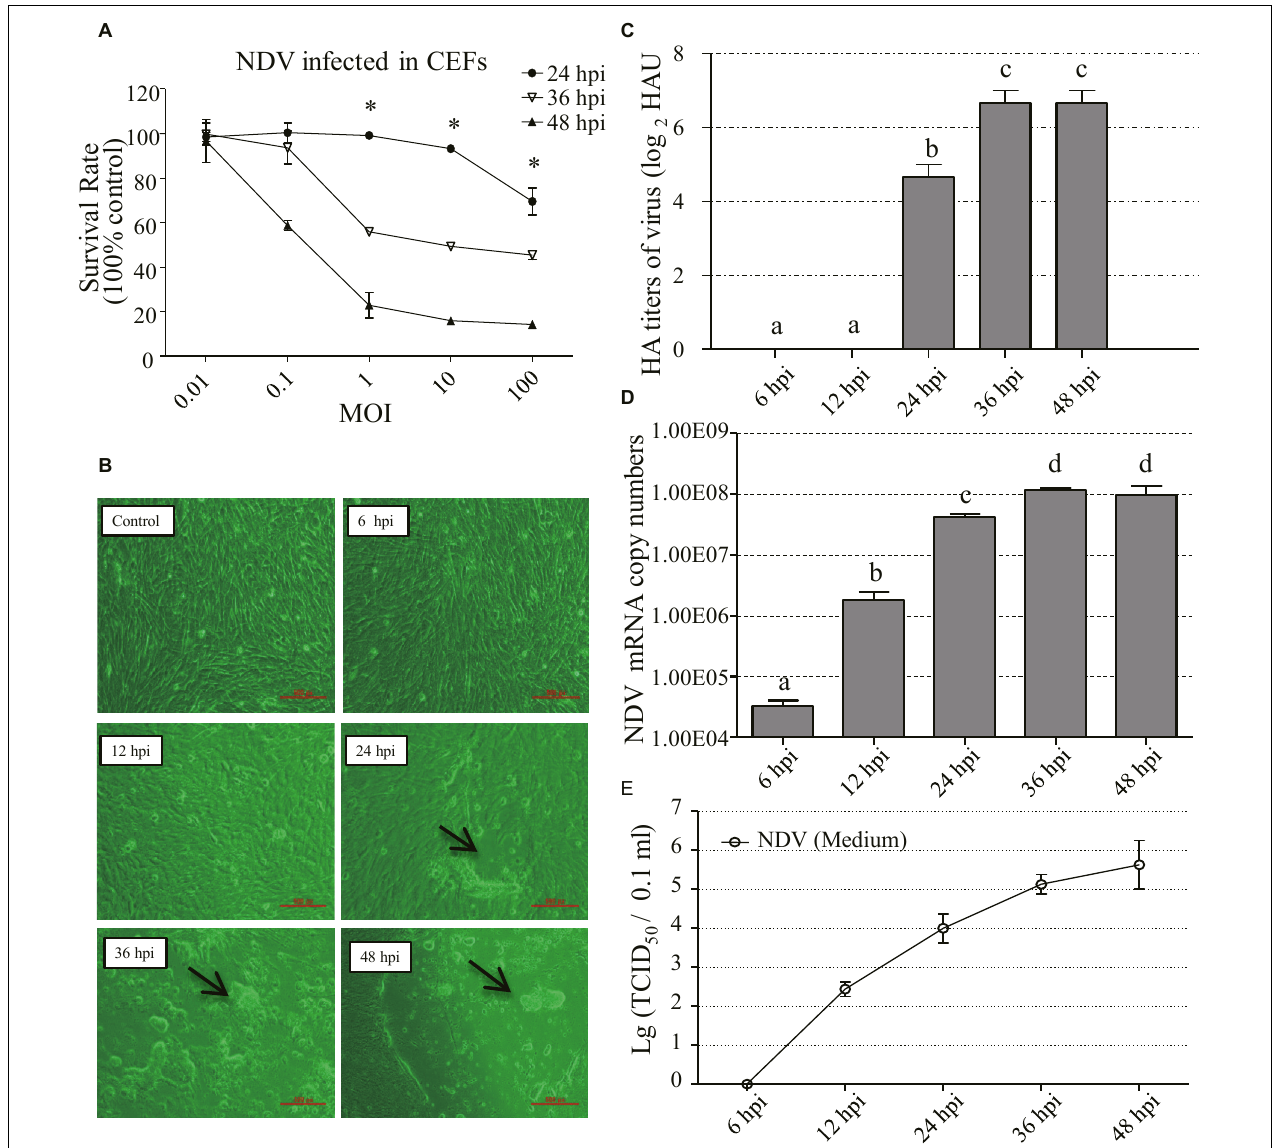
FIGURE 1 | Biological characterization of NDV-F48E9 infection in CEFs. (A) Survival rate of NDV infected CEFs in different MOI at different time points. CCK-8 was used to detect cell viability. Absorbance was measured at a wavelength of 450 nm by using a microplate reader (model 680; Bio-Rad Laboratories, Hercules, CA, United States). Protective rate was described as previous reports (Pauwels et al., 1988; Gong et al., 2010). Each group has three replicates. The difference between the same MOI at three different infection time points is represented by ∗ p < 0.05. (B) Cytopathic effect of NDV at 6, 12, 24, 36, and 48 hpi. Black arrow indicated the syncytia induced by NDV. (C) HA titer of the supernatants of NDV-infected cells. (D) Viral RNA copy numbers measured by RT-PCR in CEFs infected with NDV. (E) TCID 50 of the supernatants of NDV-infected cells. All assays were performed in triplicates. Each bar is the mean ± SEM. a , b , c , d The values with different letters are significantly different ( p < 0.05)